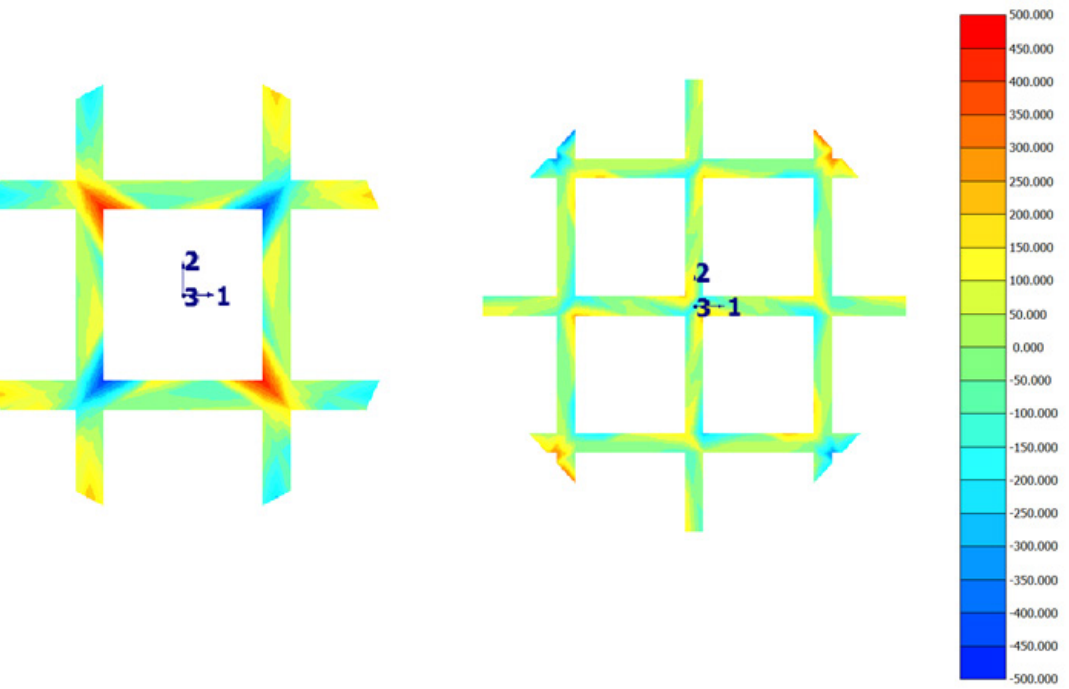
= 300 kPa: left – sample reinforced with Basetrac ® Grid PP 3